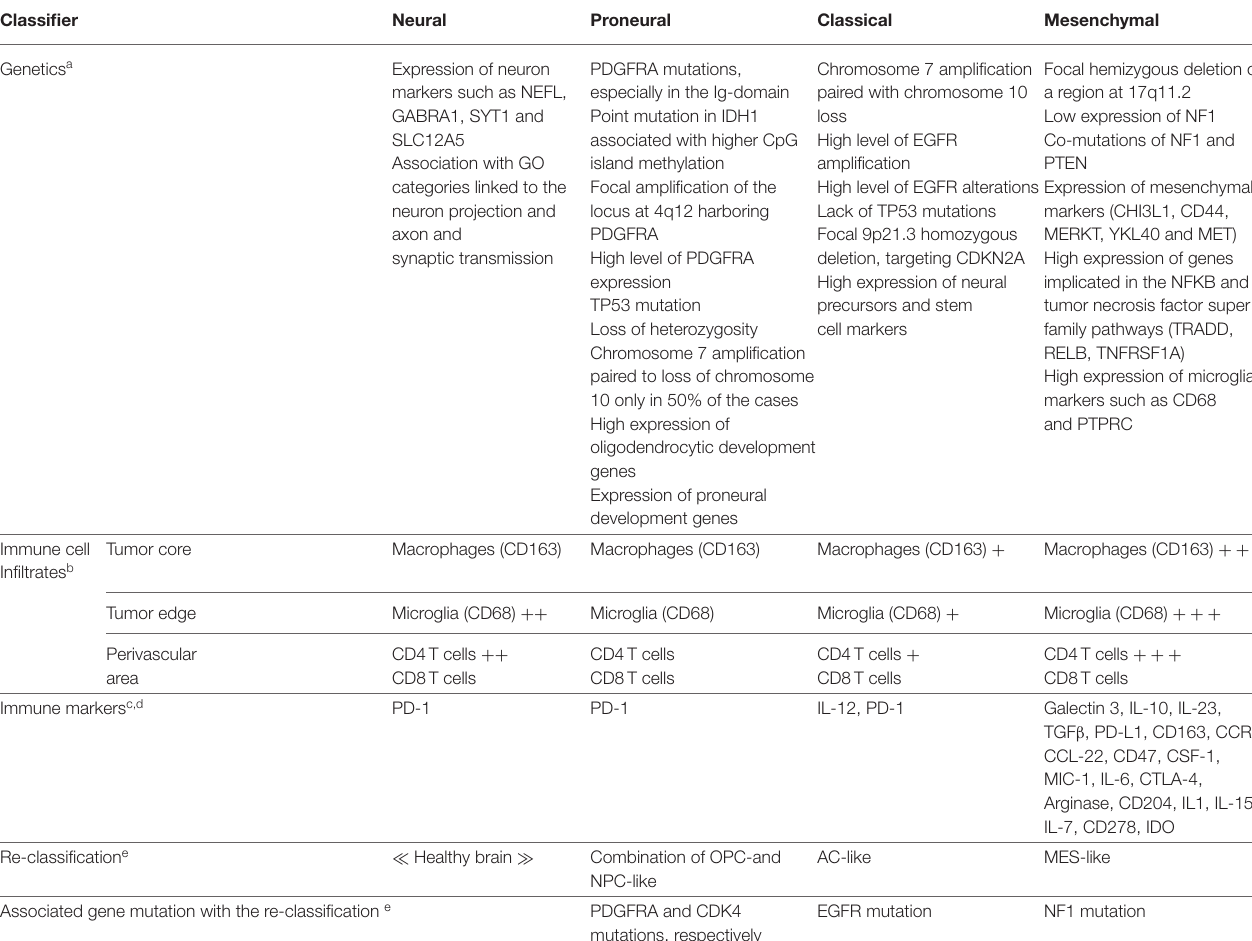
TABLE 1 | GBM molecular classification and associated immune